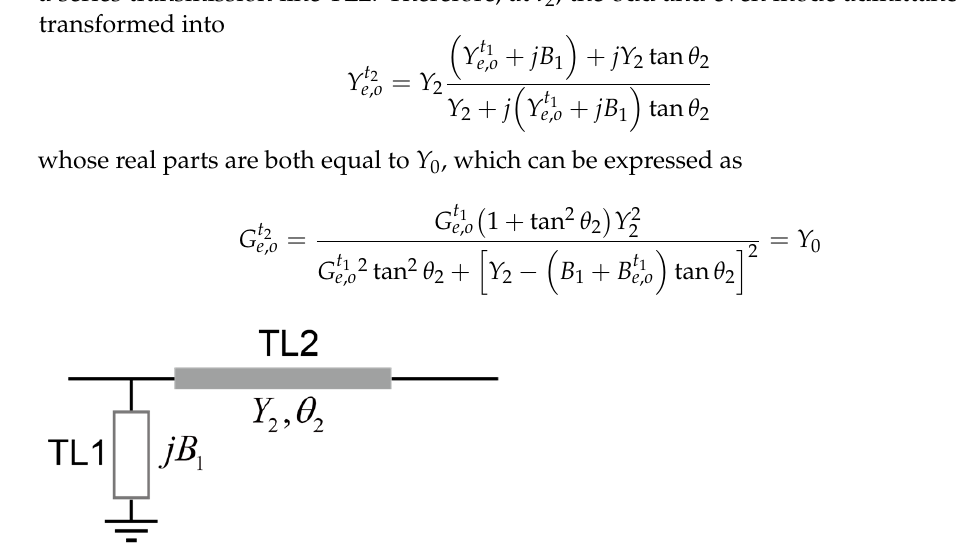
Figure 3. Diagram of the admi tt ance transforming circuit.